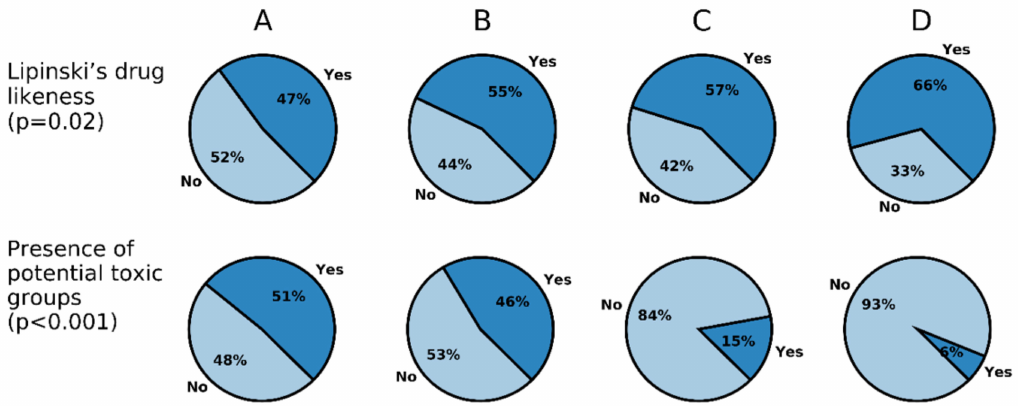
Figure 15. Comparison between the proportion of Lipinski drug-likeness as well as the presence of potential toxic (“mutagenic”) groups across activity classes. The p -values were calculated with Fischer’s [93] test adjusting the false discovery rate using the Benjamini-Hochberg procedure